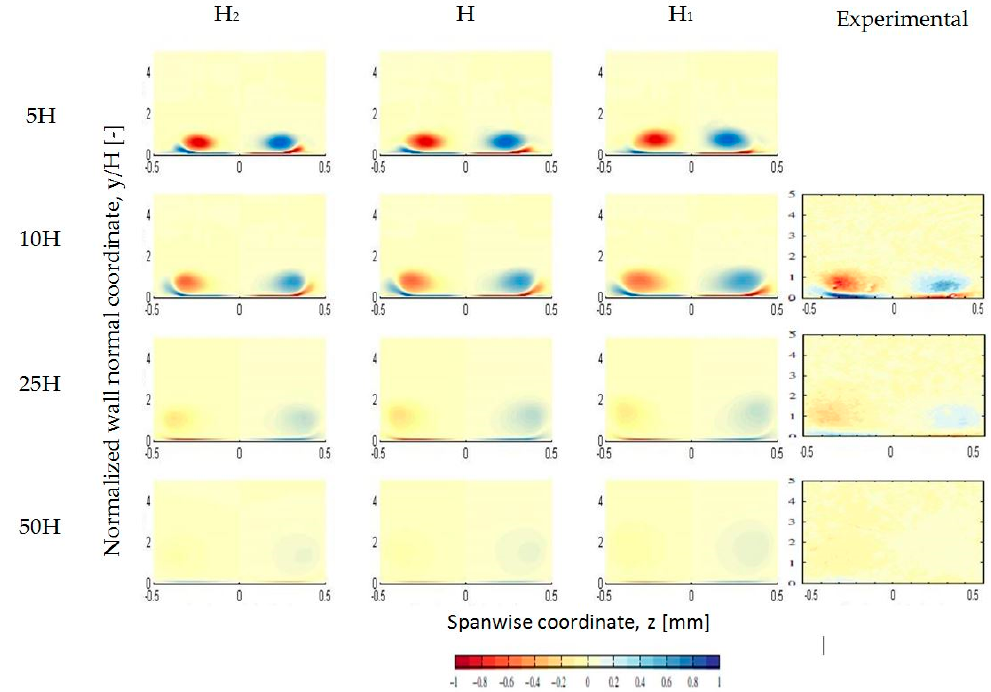
Figure 9. Comparison of the normalized streamwise vorticity ω x /( U ∞ /H) between experimental and numerical simulations. Streamwise plane positions from top to bottom: 5H, 10H, 25H and 50H.